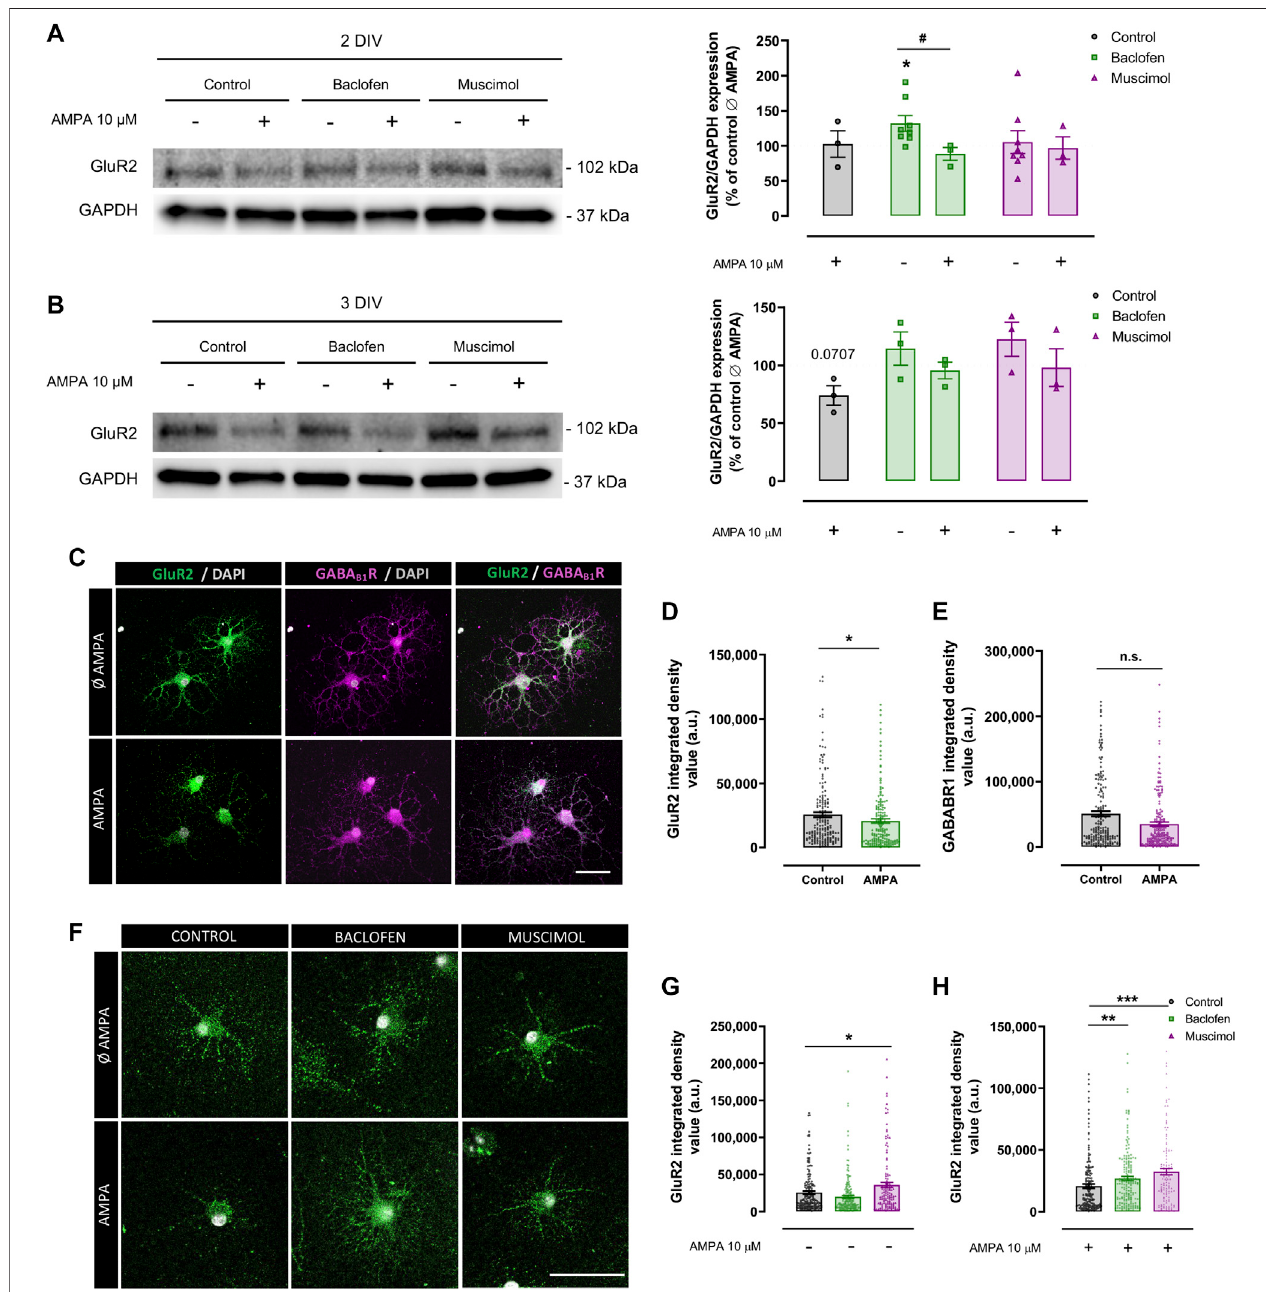
FIGURE 2 | Baclofen and muscimol reduce downregulation of cell-surface GluR2 subunit levels induced by AMPA in oligodendrocytes . (A) Western blot of GluR2 total protein levels normalized to GAPDH in oligodendrocytes treated daily with baclofen or muscimol and analyzed at day 2 in vitro (2DIV), 24 h after exposure to AMPA. (B) Western blot of GluR2 total protein levels in oligodendrocytes treated daily with baclofen or muscimol and analyzed at day 3 in vitro (3DIV), 24 h after exposuretoAMPA.InbothAandB,allconditionswerenormalizedtocontrolvaluesfromnon-treatedcultures. Dataareshown asthemean±SEMofatleast 3independentexperiments.*p < 0.05vs.controlØAMPA;#p < 0.05vs.control;one-wayANOVA. (C,F) Representative imagesofsumrepresentation (C) orsinglestack (F) of oligodendrocytes treated or not with AMPA and/or baclofen or muscimol and stained with mouse anti-GluR2 extracellular (green) and/or rabbit anti- GABA B R1 extracellular (magenta) and DAPI (grey). Scale bar: 50 µm. (D, E) Integrated density values of GluR2 or GABAB R 1 fl uorescence signal, respectively. (G, H) Integrated densityvaluesofGluR2inoligodendrocytesunderdifferenttreatments.Dataareshownasthemean±SEMofatleast123individualcells.*p < 0.05,**p < 0.01,***p < 0.001 vs. control without or with AMPA respectively; one-way ANOVA for multiple experimental groups comparisons; unpaired t test for two experimental group comparison.